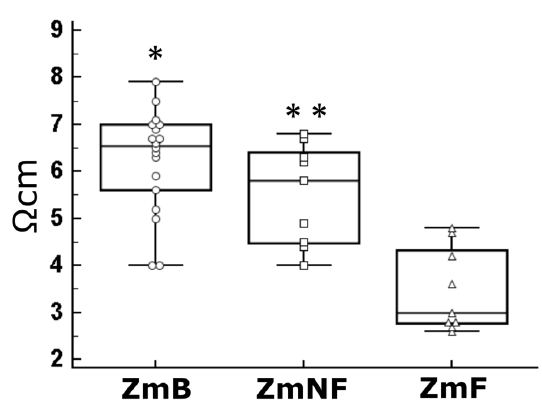
Fig.5. The experimental data obtained from one of the four studied animals and concerning the electrical impedance values (Z m ) of the slaughtered meat in the base condition (Z mB ), non- frozen (Z mNF ) and frozen and thawed (Z mF ) conditions, are represented as box and whiskers diagrams with markers (empty symbols) that reveal the distribution of each measurement. With respect to Z mF : (*) P = 0.004; (**) P =